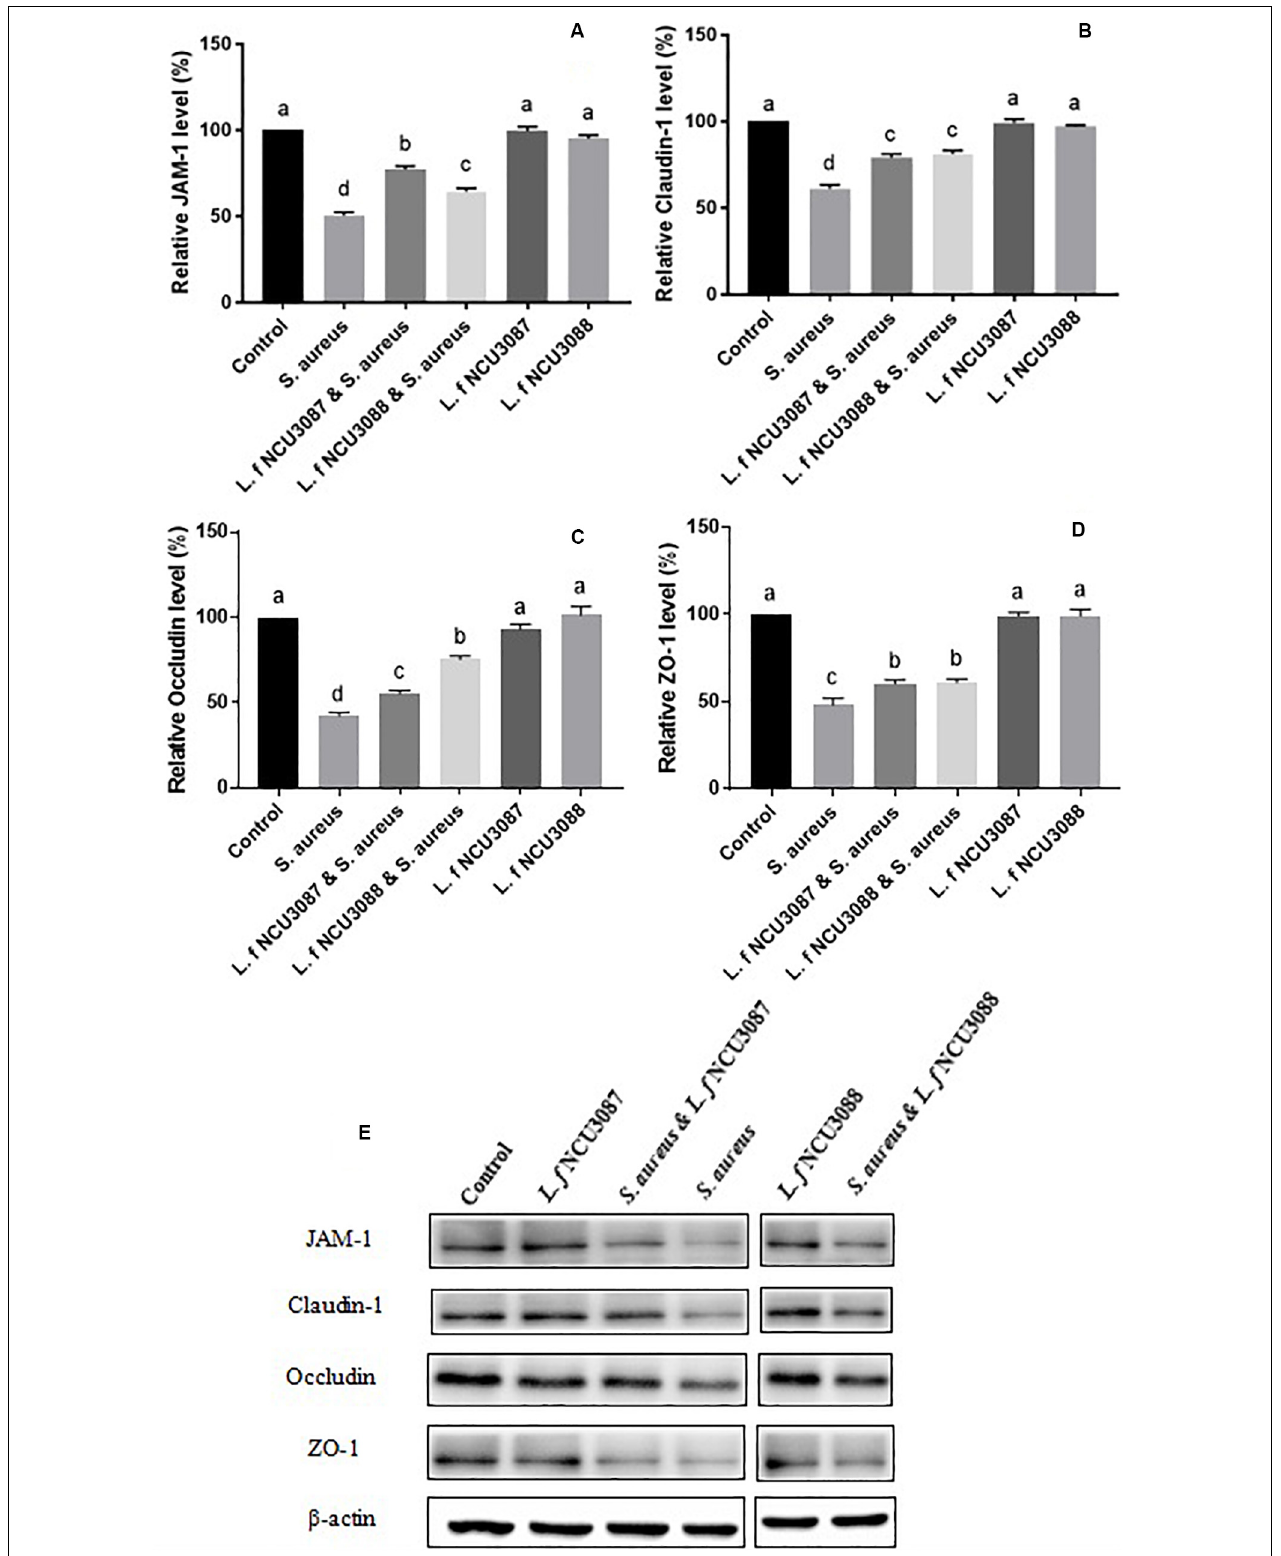
FIGURE 2 | Quantification of JAM-1 (A) , Claudin-1 (B) , Occludin (C) , and ZO-1 (D) of Caco-2 cells treated by bacteria via Western blot analysis (E) . Different letters indicate statistically significant differences between variables.